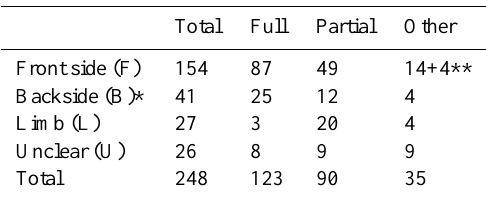
Table 1. Summary of all halo CME observations by LASCO